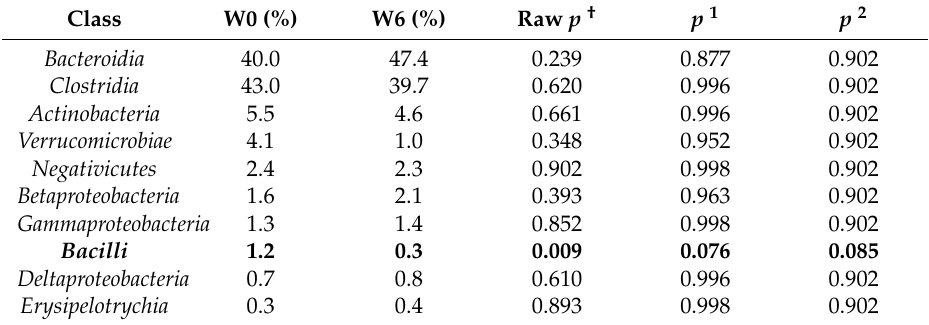
Table 4. Comparison of taxon abundance between the two time points (W0 and W6) at the level of class.